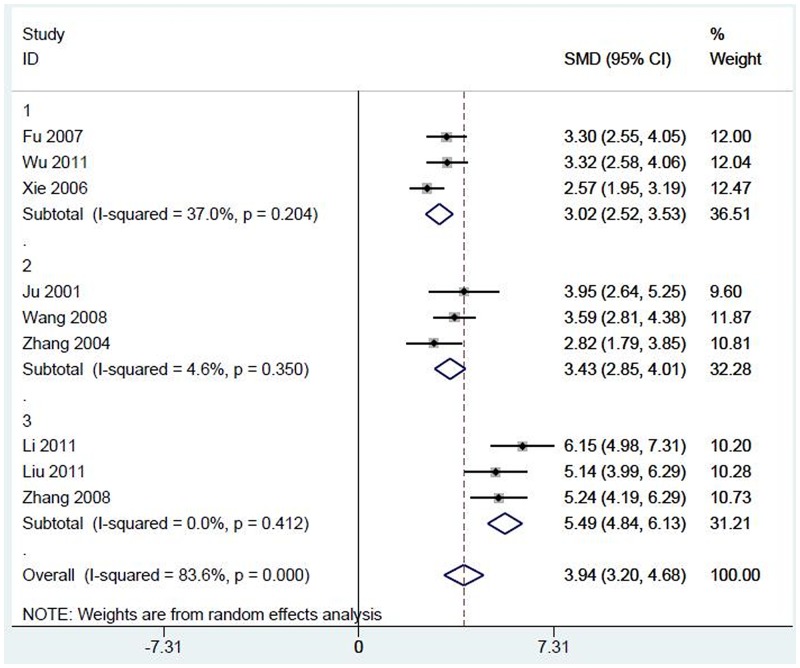
Meta-analysis of the association of serum TGF-β1 levels with the risk of diabetic nephropathy: subgroup analysis according to diagnostic criteria.SMD, standardized mean difference.